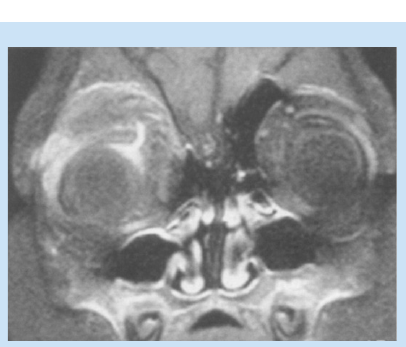
Fig 1e. Coronal FLAIR image showing hyperinten- sities within the cerebellar white matter. All lesions had remained radiologically stable for 2 years.